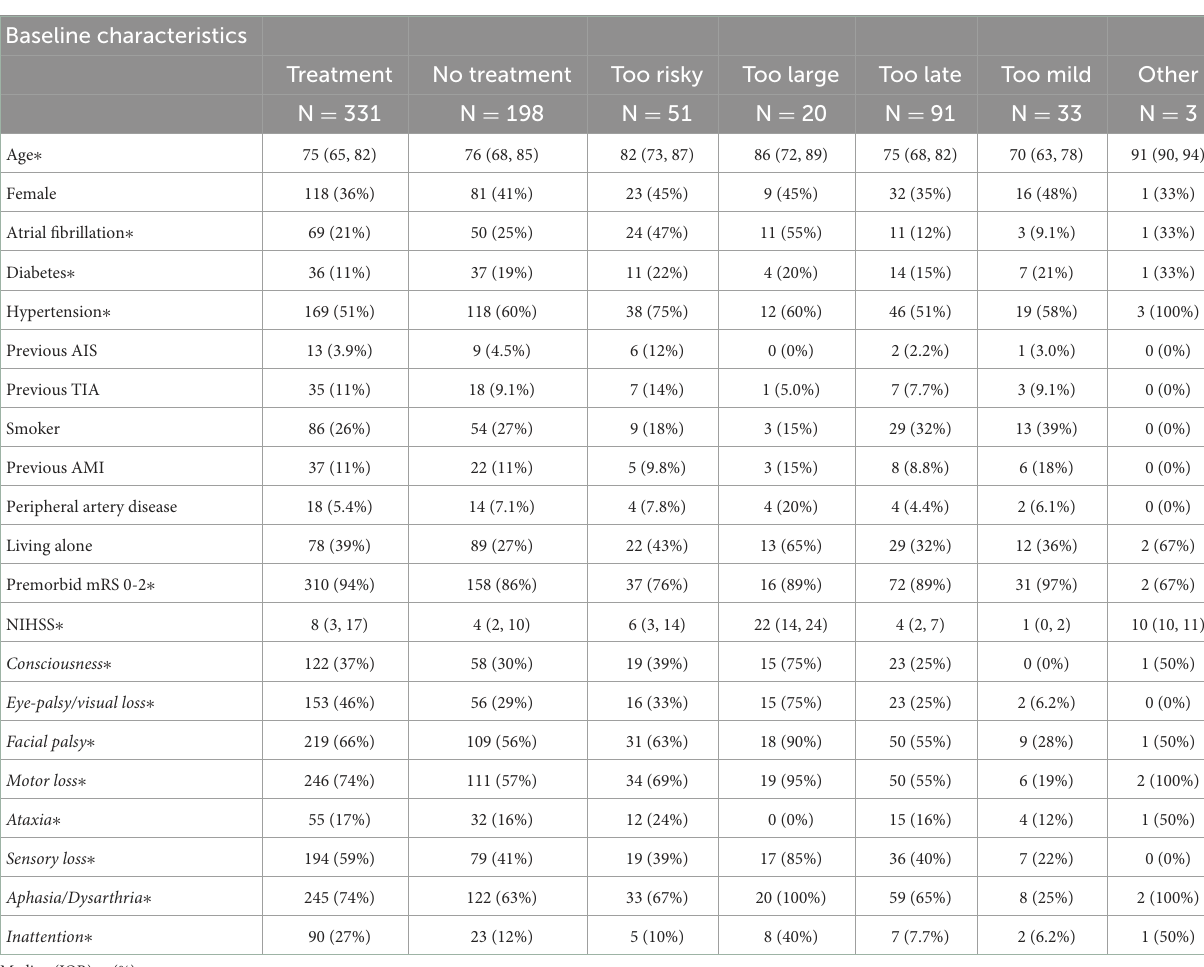
TABLE 2 Baseline characteristics of all treated and not treated